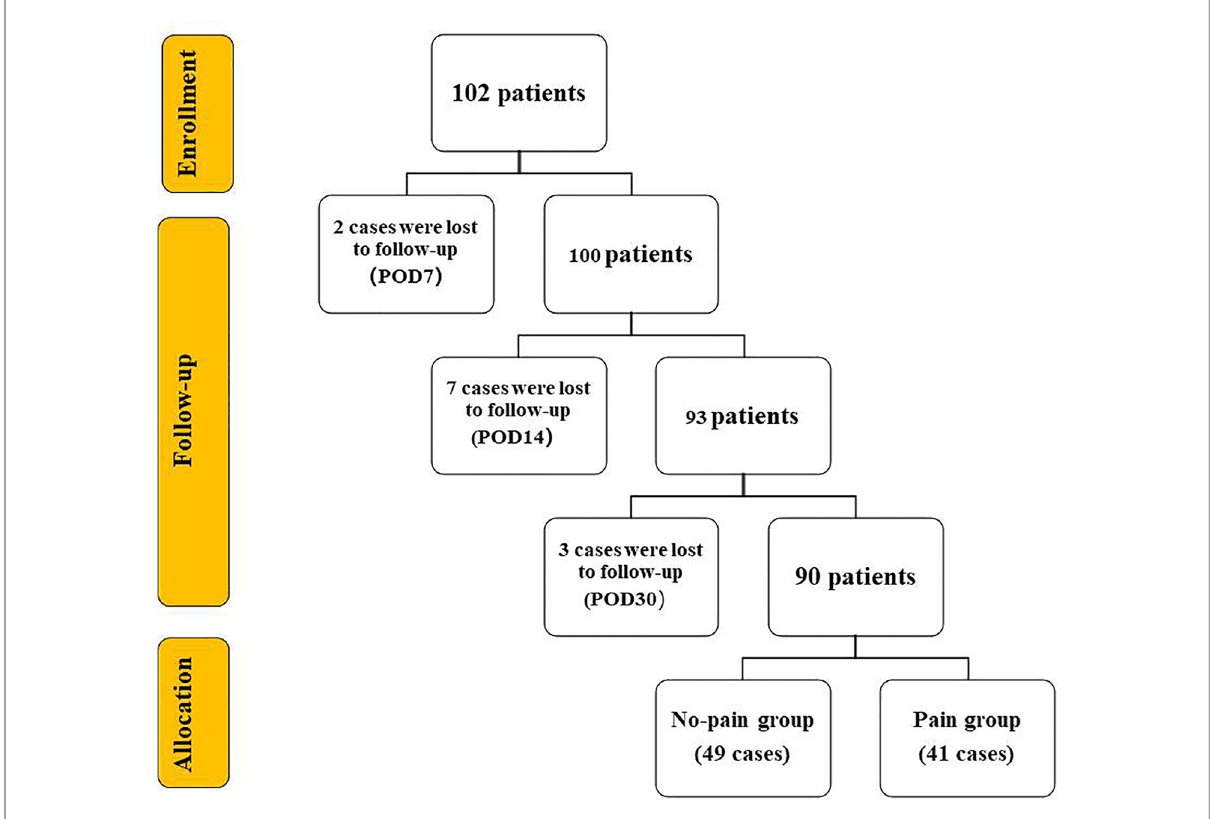
FIGURE 1 Flow chart. The number of patients decreased with the extension of follow-up. A total of 90 patients completed all follow-up on the 30th day after surgery. They were divided into two groups according to whether they had active pain or not. POD=Postoperative